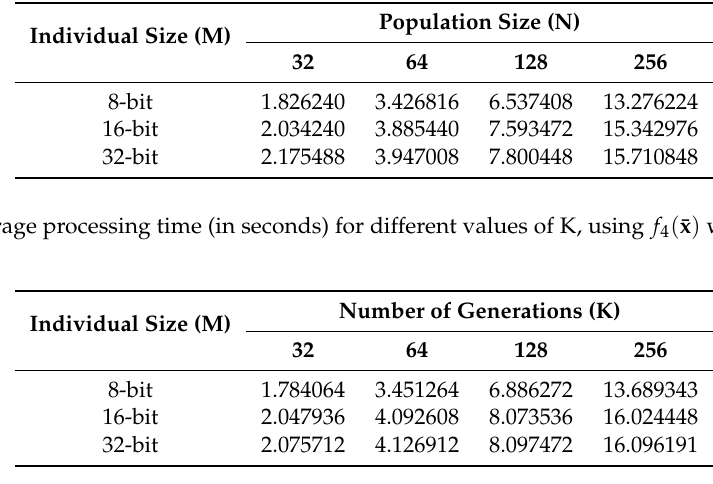
Table 7. Average processing time (in seconds) for different values of N, using f 4 ( ¯x ) with K = 8 and D = 1.